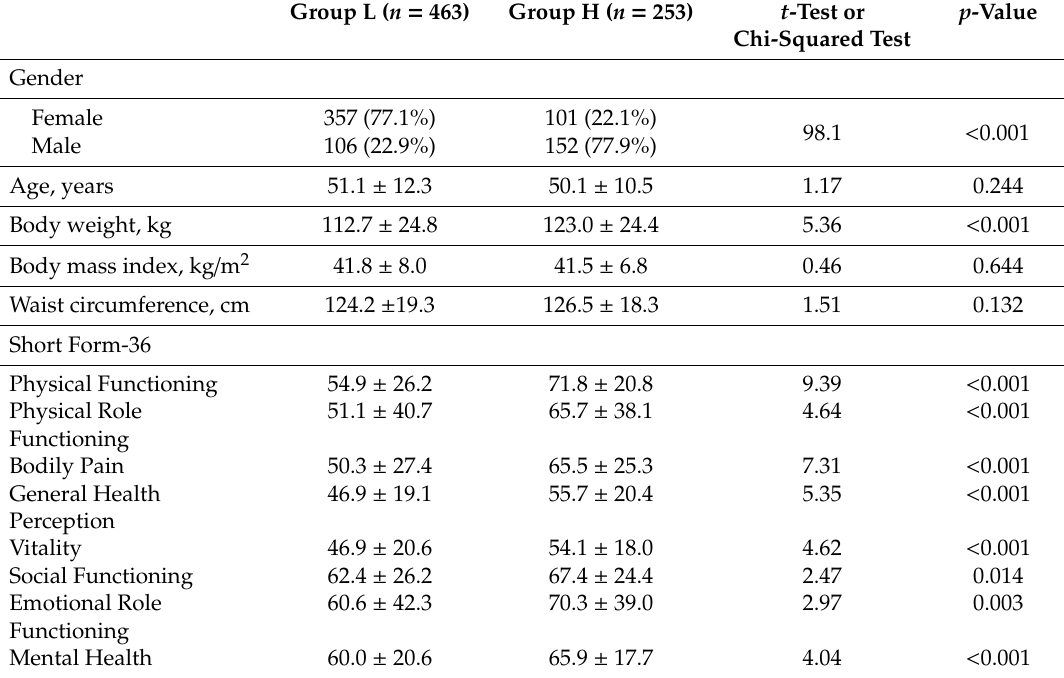
Table 1. Demographic and clinical characteristics of patients with obesity walking as far as or farther than predicted during the six-minute walking test (Group H), and of patients with obesity walking less than predicted during the six-minute walking test (Group L). Data are presented as mean ± SD or number (%), as appropriate. p Group L ( n = 463) Group H ( n = 253) t -Test or Chi-Squared Test